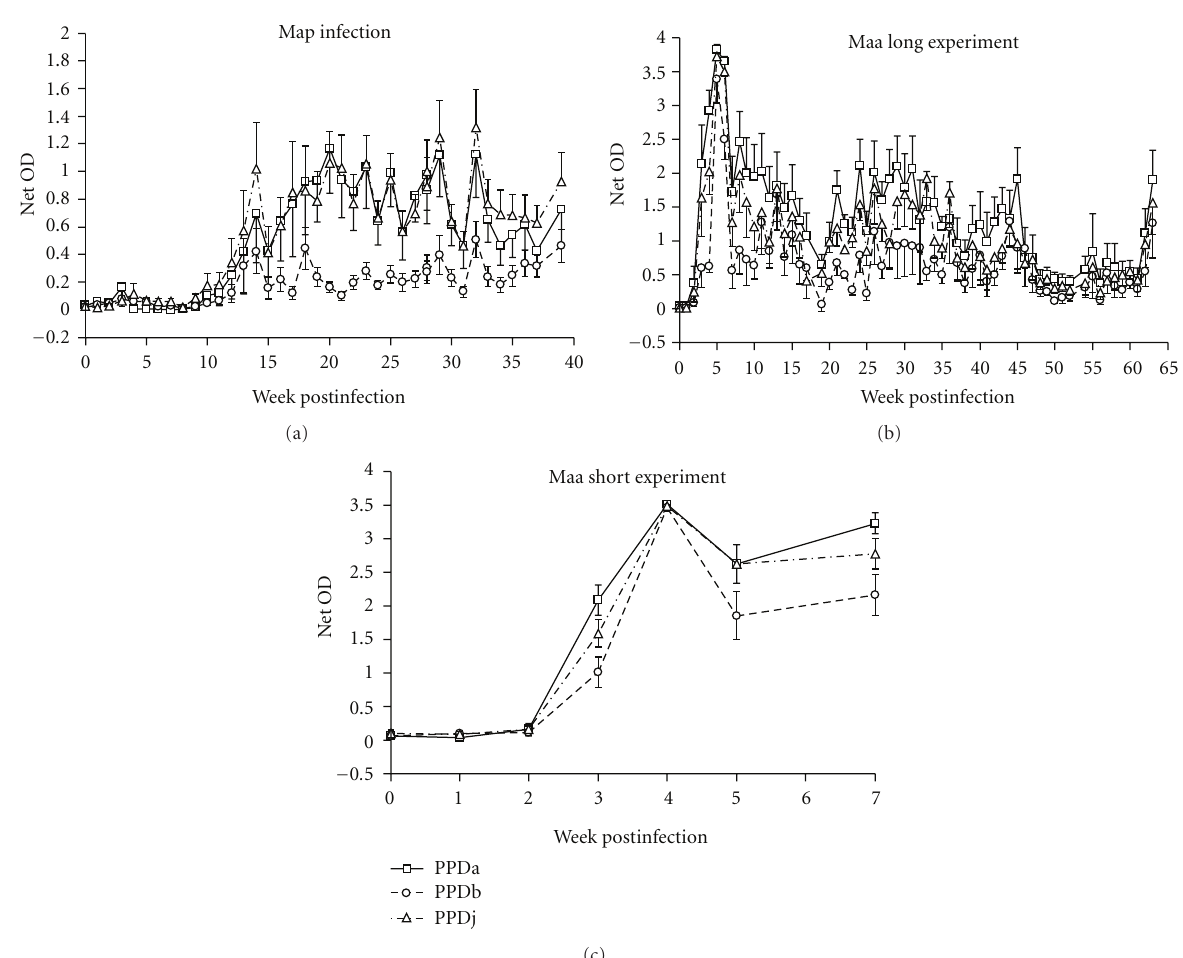
by callipers and injected intradermally with 100 μ L PPDa (VLA), PPDb (VLA), and PPDj (CVI) tuberculins. Each injection site was checked to ensure intradermal